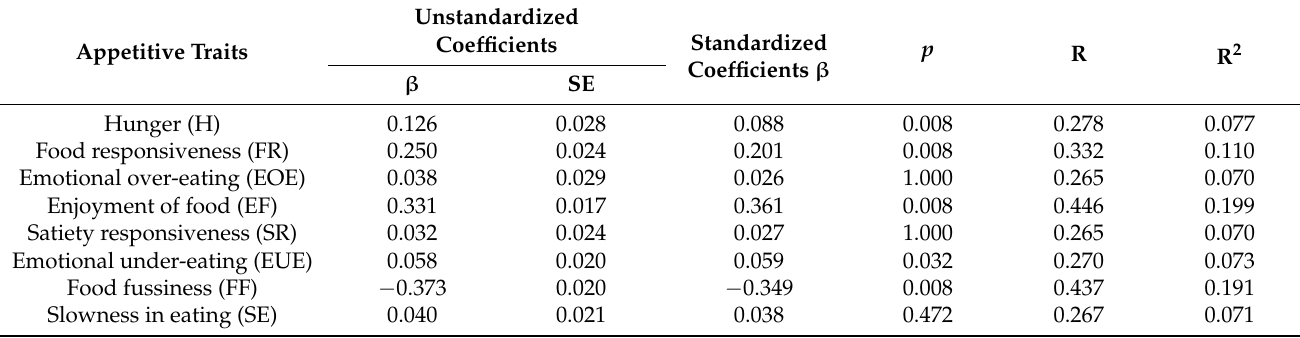
Table 7. Analysis of association between appetitive traits and meat/fish preference assessed by Food Preference Ques- tionnaire (FPQ) (model adjusted for sex and age) within the population of the second phase of the Polish Adolescents’ COVID-19 Experience (PLACE-19) Study ( n = 2425).